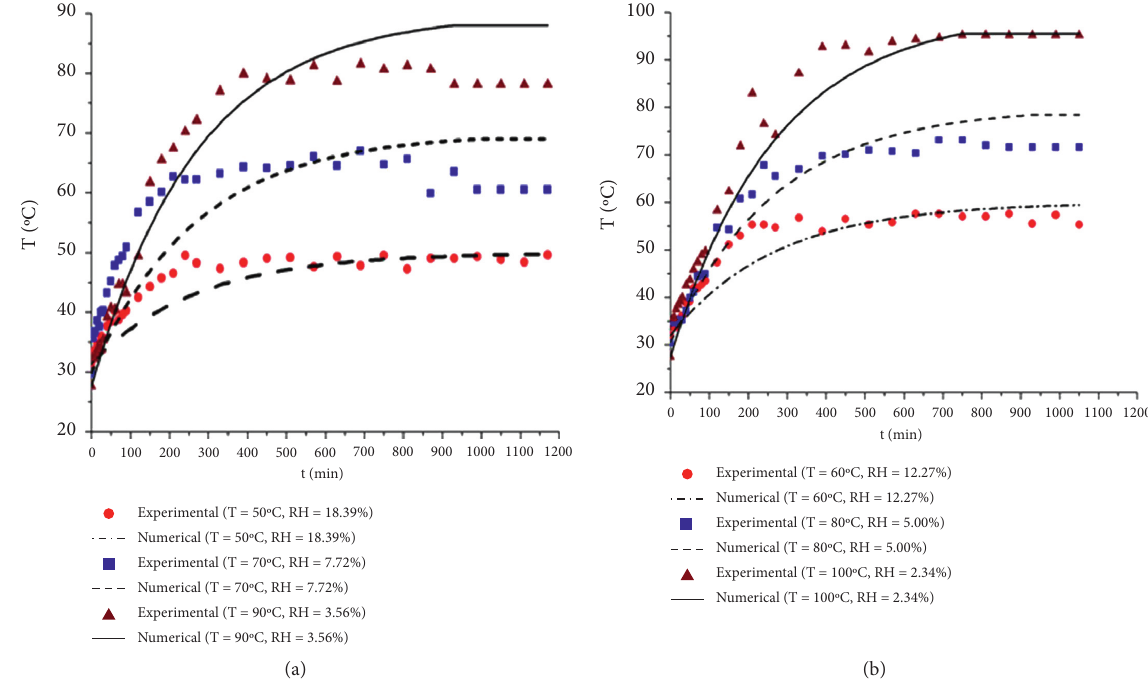
Figure 8: Heating kinetics on the surface of the industrial brick at different drying-air temperatures. (a) T � 50 ° C, 60 ° C, and 70 ° C. (b) T � 80 ° C, 90 ° C, and 100 ° C.